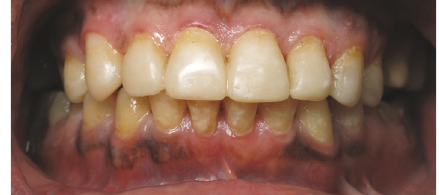
Figure 6: Composite build-up as long-term temporization.